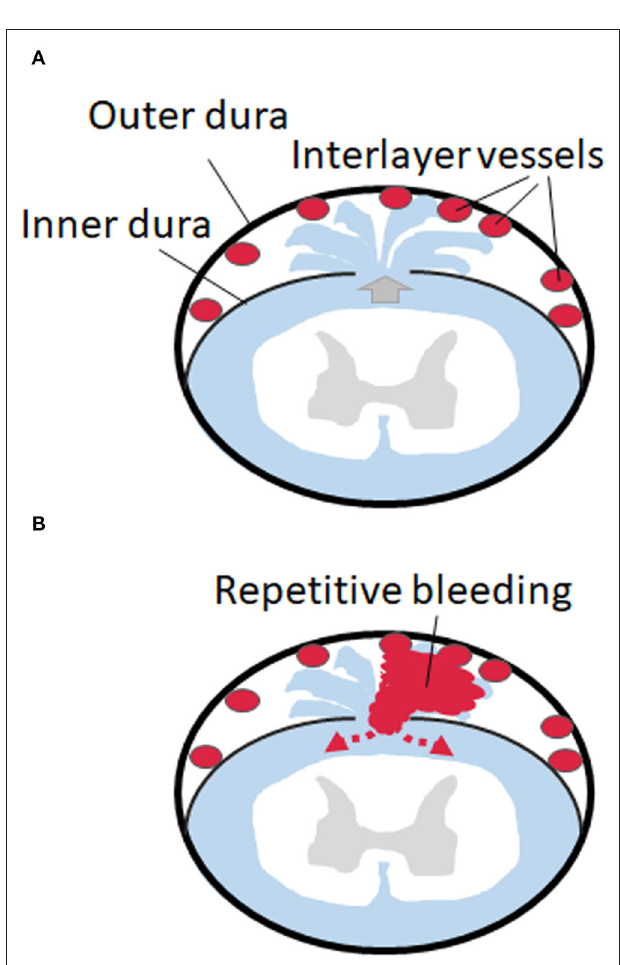
FIGURE 4 | Schemes of the dural dissection and bleeding form the dissected space. (A) Dural tear at the inner dural layer causes “dural dissection” between the outer fibrous thick layer and the inner thin layer. A CSF leak causes venous dilatation in the inter-layer space. (B) The receptive dynamic CSF flow into the dissected space causes the chronic bleeding from the rich-dilated vessels localized between the inner and outer layers, which circulate back to the subarachnoid